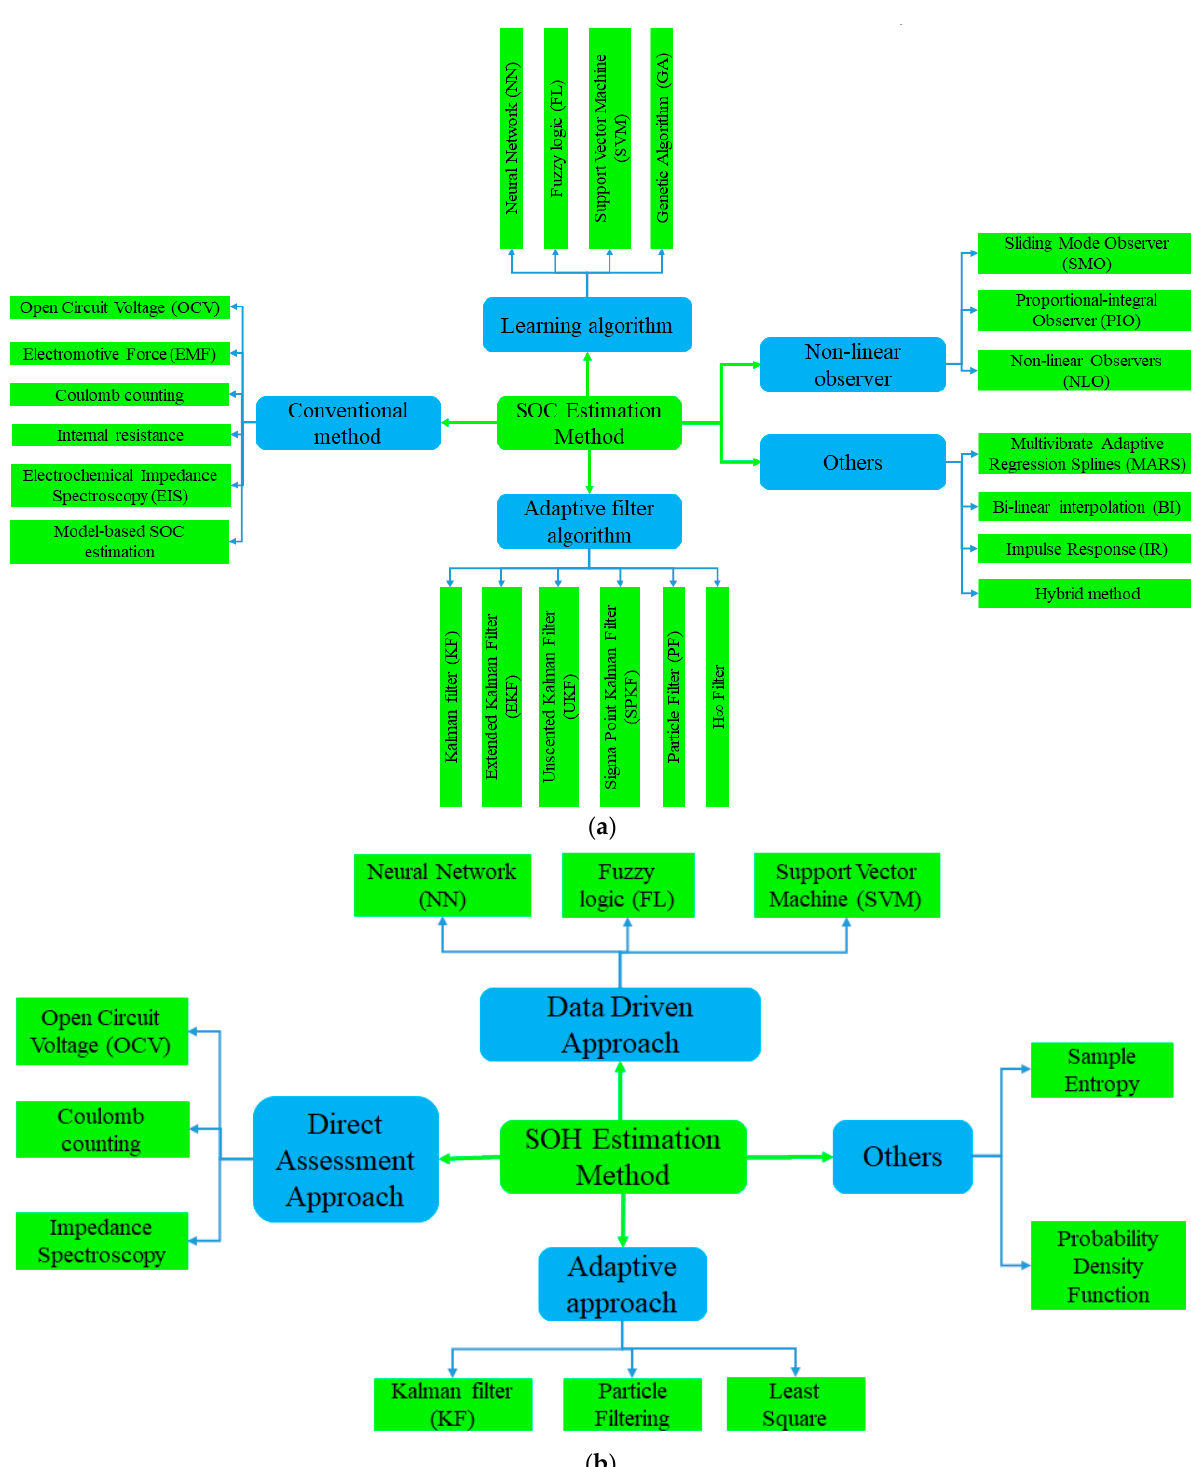
Figure 8. Taxonomy of SOC and SOH estimation method, ( a ) SOC estimation; ( b ) SOH estimation.